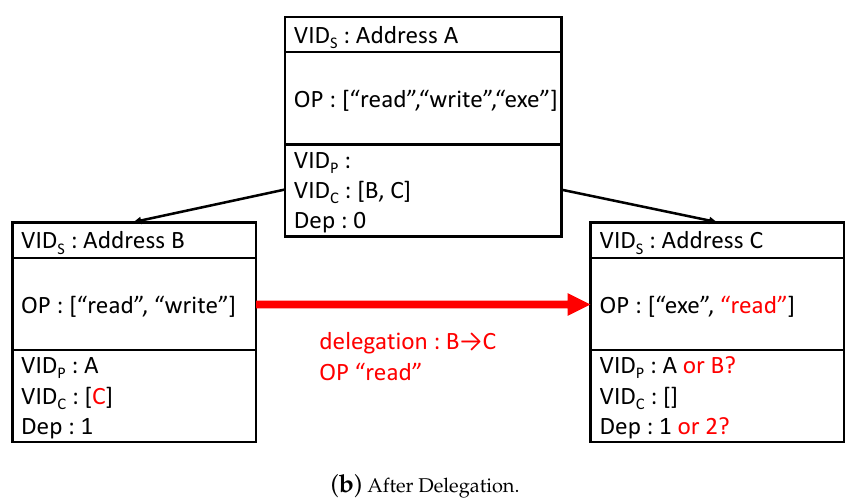
Figure 3. Delegation Tree in the BlendCAC